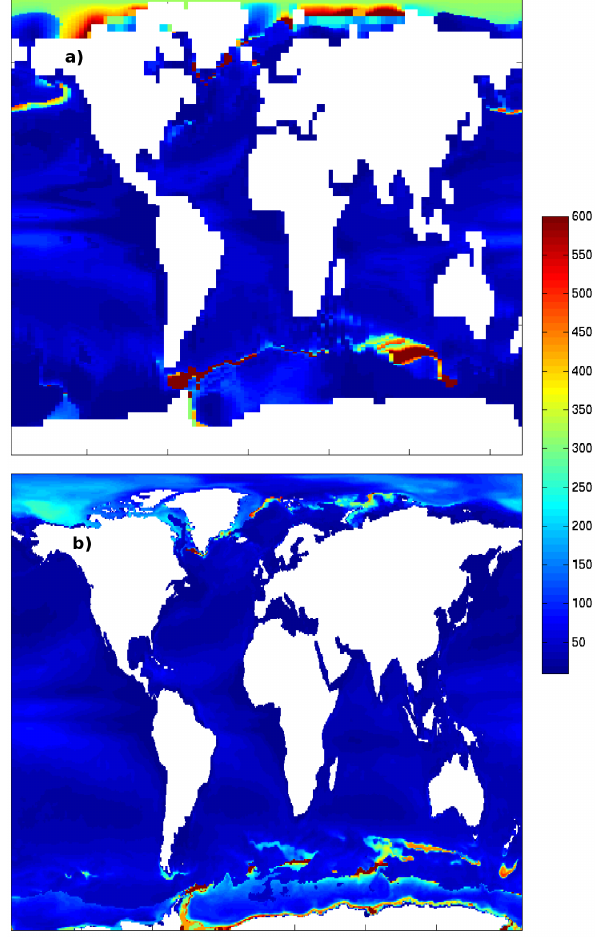
Fig. 14 Fig. 14. Annual mean mixed layer depth in the ocean (m) following the temperature criterion as described in Levitus (1982). (a) HOPE- G, and (b) for the SODA dataset (Carton and Giese, 2008; Carton et al.,